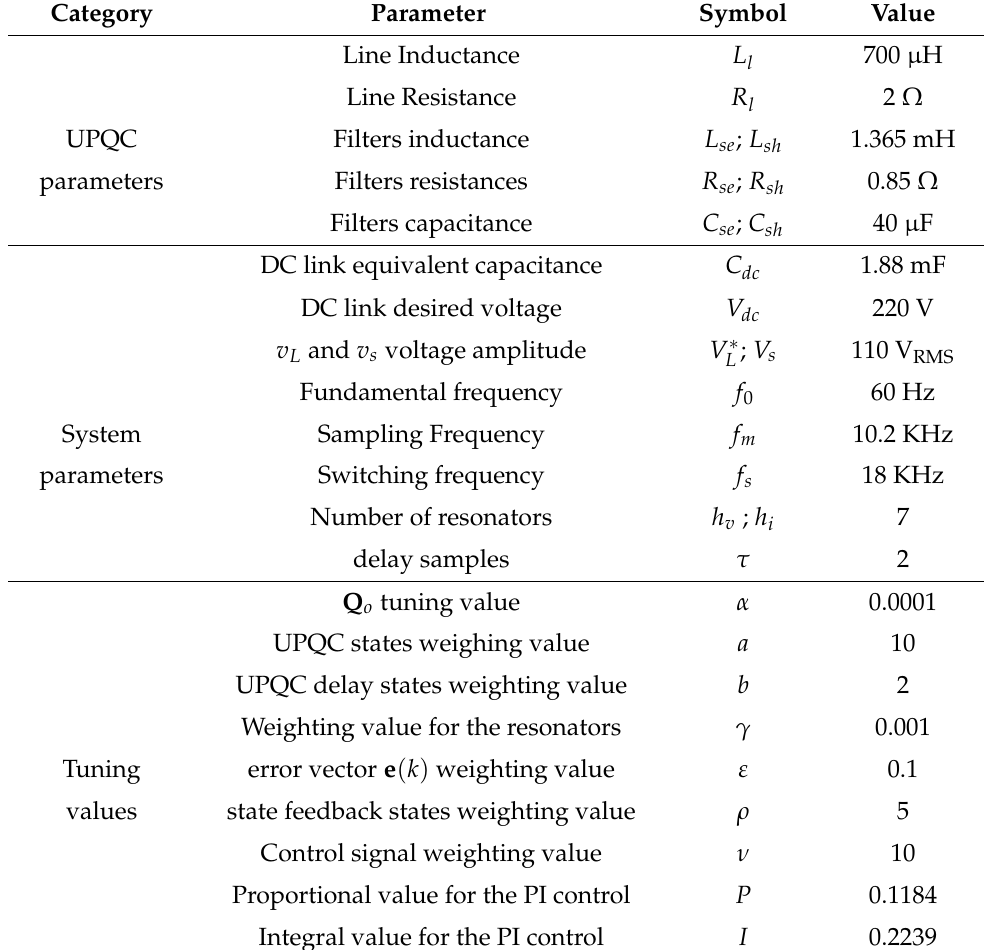
Table 1. Values for the parameters used in the UPQC experimental